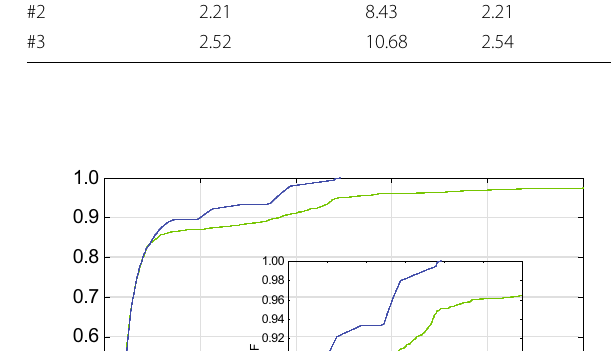
ELM, + predictive model/ELM in the + predictive FIR ELM FIR predictive + + + model model/ELM